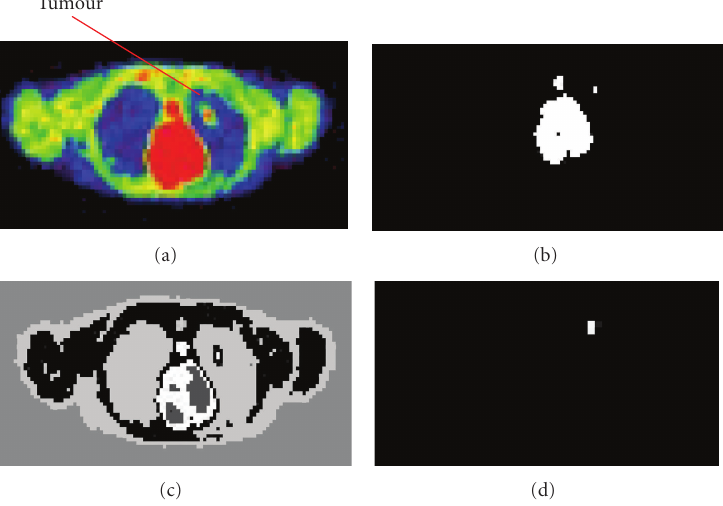
Figure 7: Phantom data set 2. (Tumour 1): (a) Original PET image (128 × 128), (b) thresholded image (128 × 128), (C) clustered image (128 × 128), (d) segmented image (64 × 64) using ANN and MRA, zoomed by a factor of 2, where tumour 1 (2 voxel) is detected.